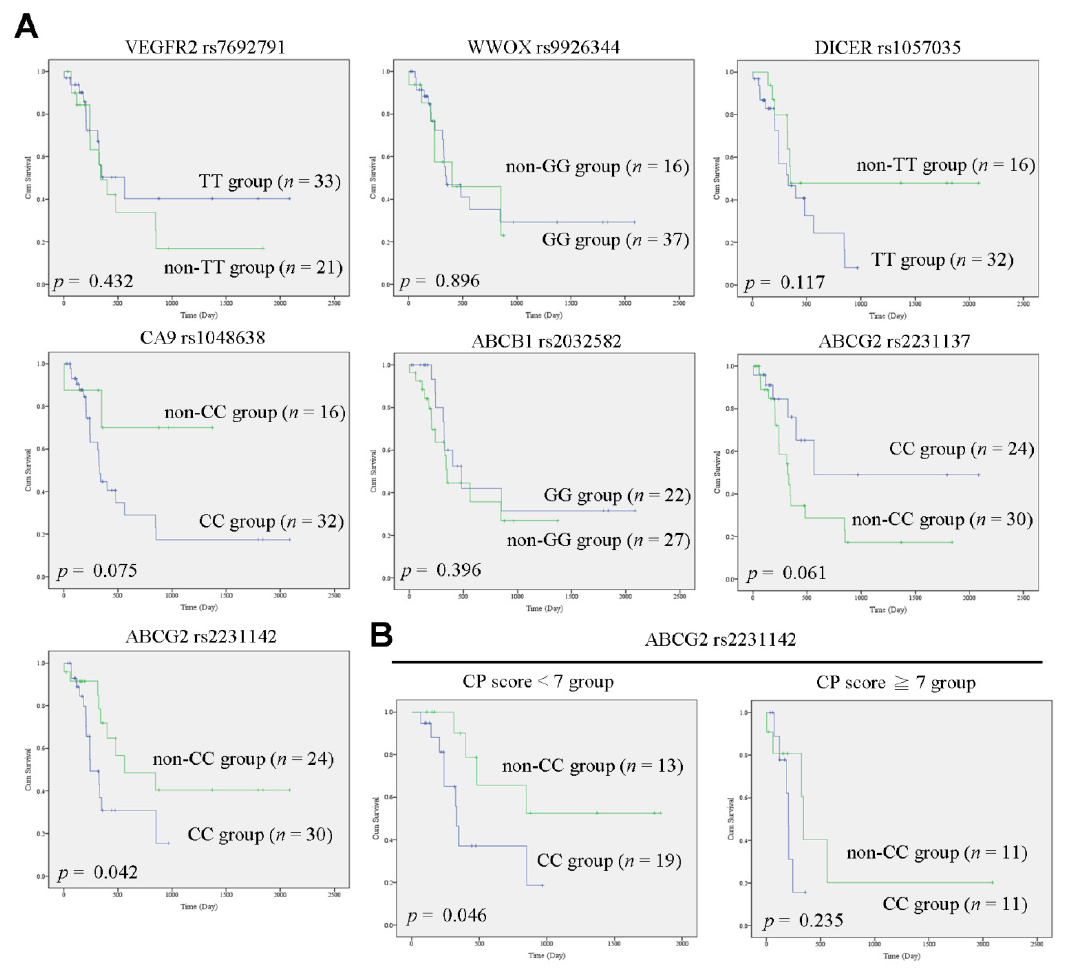
Figure 1. The ABCG rs2231142 polymorphism is correlated with the overall survival of HCC patients receiving sorafenib. ( A ) The clinical significances of VEGFR2 rs7692791, WWOX rs9926344, CA9 rs1048638, DICER rs1057035, ABCB1 rs2032582, ABCG2 rs2231142, and ABCG2 rs2231137 were calculated using Kaplan–Meier curves with log-rank analysis. ( B ) The clinical significance of ABCG2 rs2231142 in the CP score < 7 or ≥ 7 group is shown. Table 2. Cox proportional hazard analysis for association between clinical factors and overall sur- vival (cohort-1).